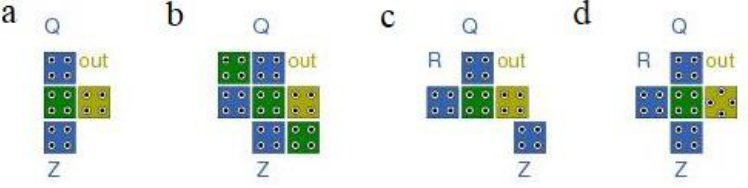
Figure 3. QCA faults; ( a ) missing cell, ( b ) extra cell, ( c ) dislocation cell, ( d ) rotated